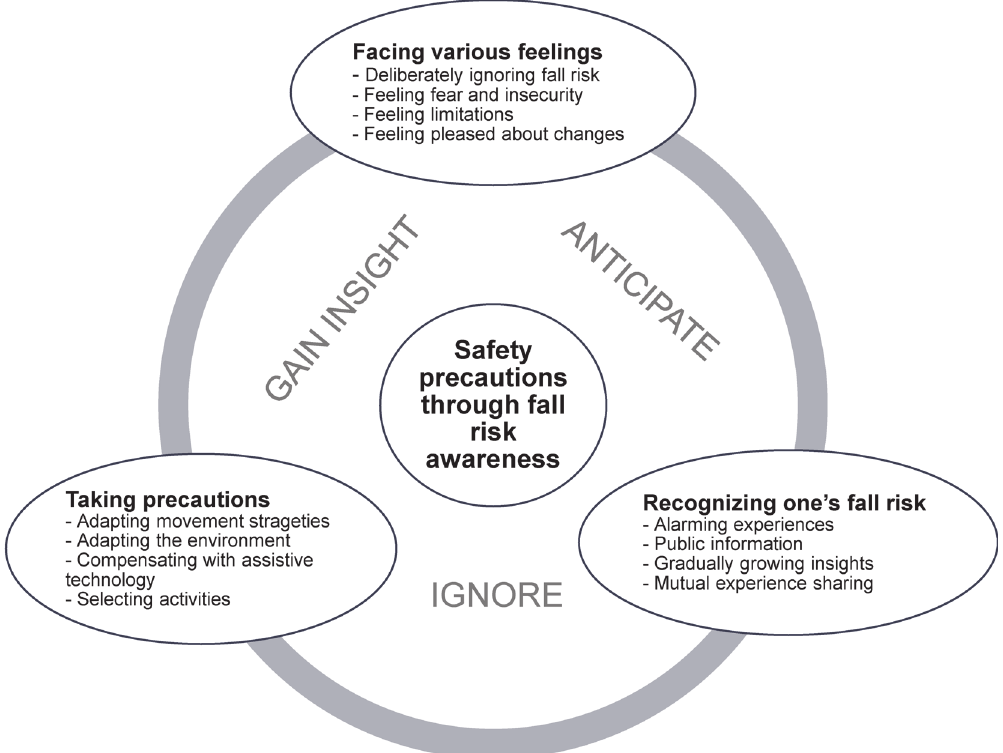
Fig 2. Three categories and one overall theme. A plausible model for development of safety precautions through fall risk awareness and related feelings in older community-dwelling women and men. Ignore, Gain insight and Anticipate are present throughout the intire process of becoming aware of fall